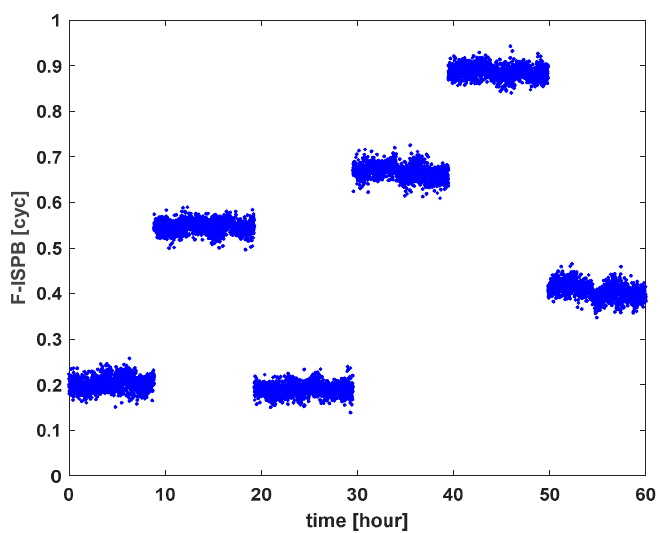
Figure 7. F-ISPB estimation results of IGG01–IGG02 baseline.